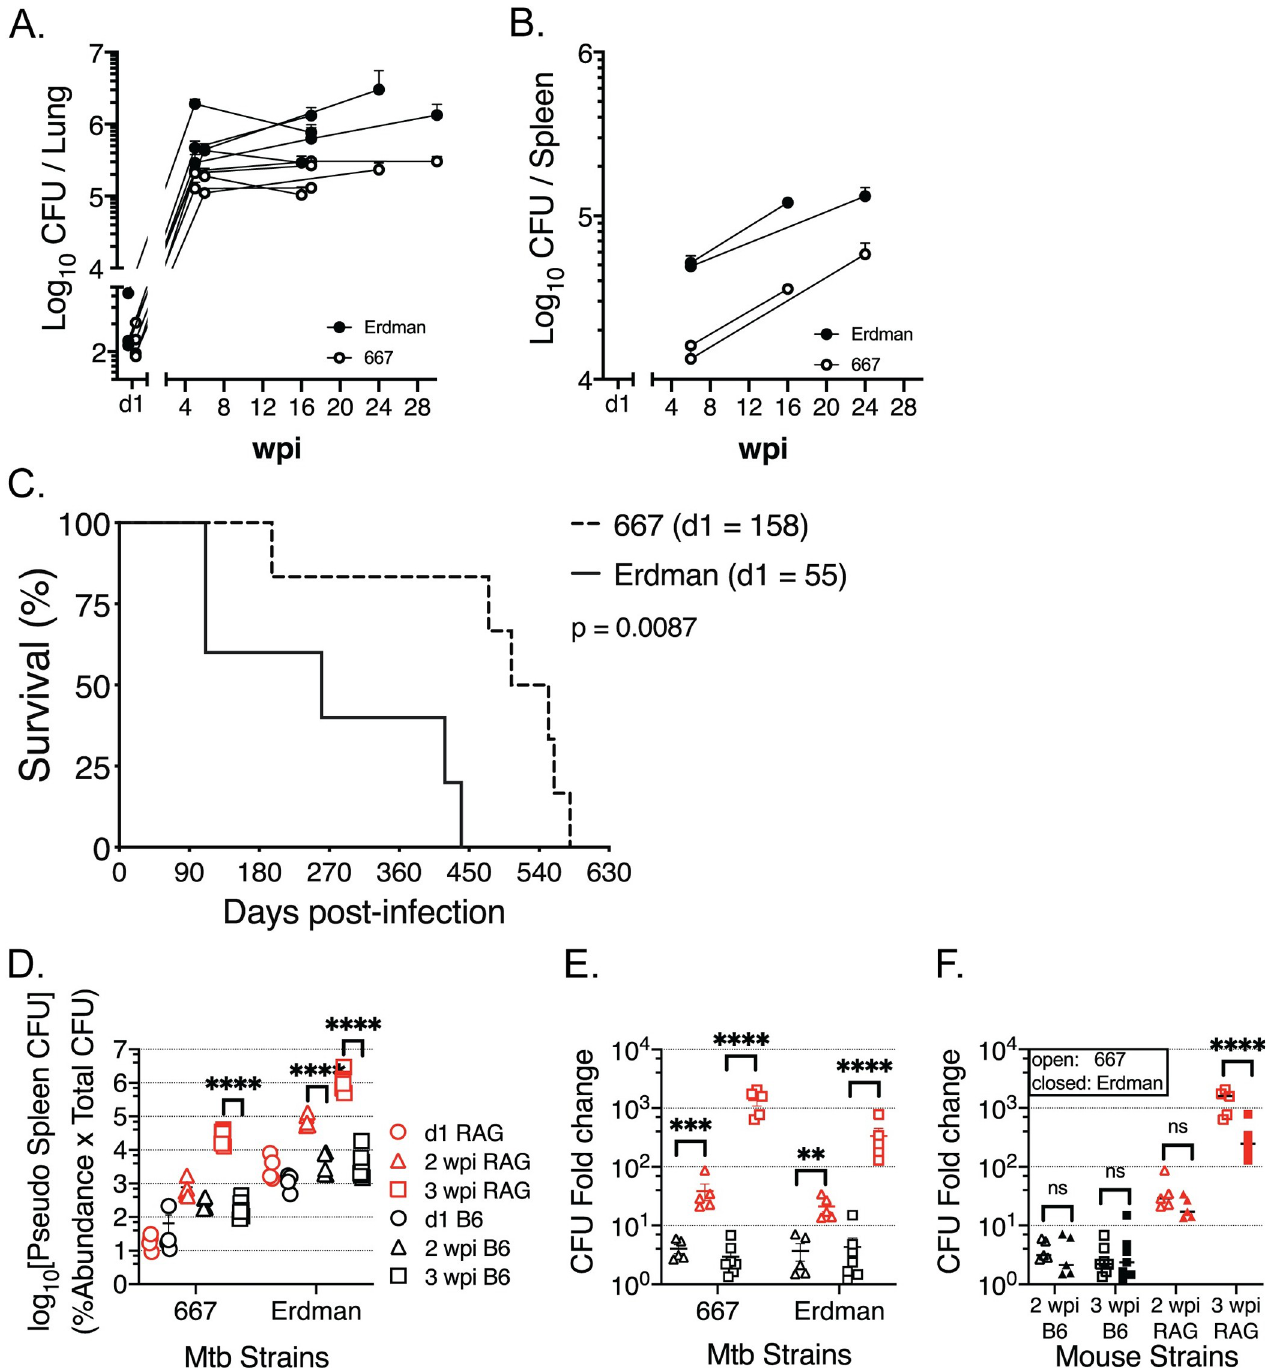
Fig 3. Infection with 667 is less virulent than Erdman. The bacterial burden is measured by CFU from lung (A) or spleen (B) homogenates from Erdman (filled) or 667 (open) infected C57BL/6J at different timepoints post infections. CFU data were compiled from 13 (lung) or 6 (spleen) independent experiments, from 4 to 30 weeks post infections. (C) The survival of C57BL/6 mice after Erdman (solid) or 667 (dashed) infection, which is one of two independent results with similar results. In this experiment, the d1 CFU was 158 (667) or 55 (Erdman). (D-E) A barcoded pool of clinical Mtb isolates was administered intravenously to C57BL/6J (black) or RAG1 KO (red) mice, and 4–8 mice of each strain were harvested for lungs and spleens to recover bacteria at 1 (circle), 14 (triangle), and 21 (square) days post infection. (D) The pseudo CFU of 667 and Erdman in spleen were determined by the relative abundance of the respective Mtb strains multiplied by total CFU in the spleen. (E) CFU fold-change (versus d1 CFU) of 667 or Erdman abundance in the spleen was compared between C57BL/6J (black) and RAG1 KO (red) mice. (F) CFU fold-change (versus d1 CFU) of 667 (open) vs. Erdman (closed) in the spleens of C57BL/6J (black) and